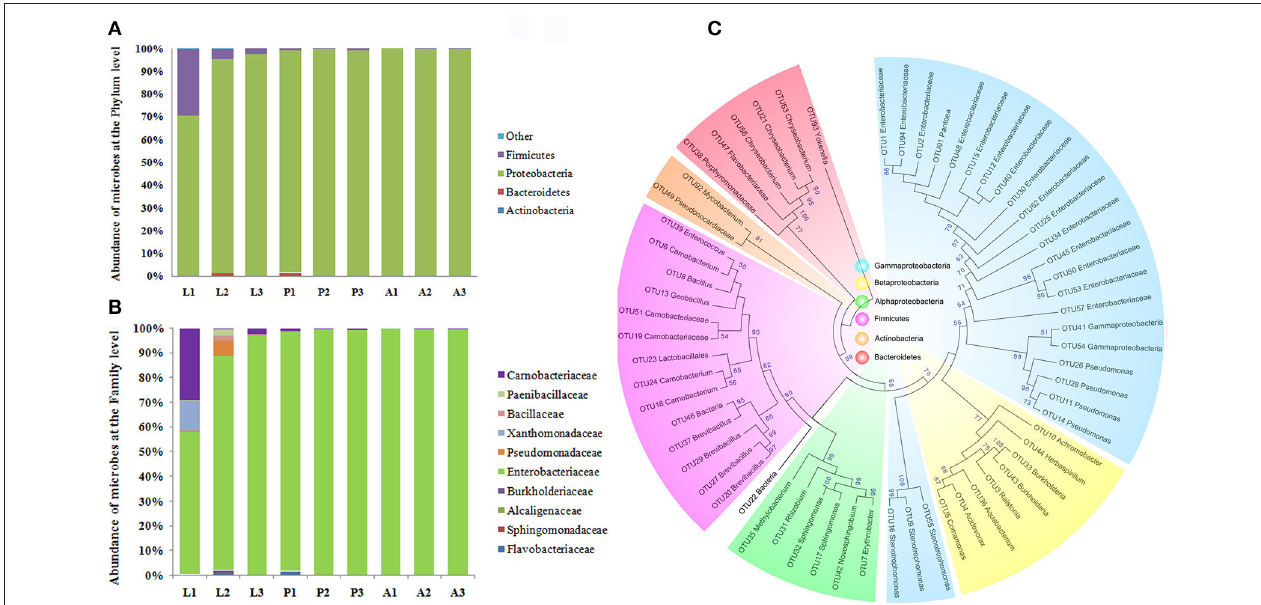
FIGURE 2 | Proportional composition of microbiota in the P. xylostella gut generated from the 454 pyrosequencing data. Composition at the phylum level (A) , and composition at the family level (B) , Neighbor-Joining method phylogeny of OTUs (C) . The phylogenetic tree revealed that the microbiota of P. xylostella gut were divided into six clusters corresponding with the phylum of Proteobacteria (Gammaproteobacteria was shown in blue, Betaproteobacteria with light yellow, and the alphaproteobacteria with green), Firmicutes (shown in purple), Actinobacteria (shown in dark yellow), and Bacteroidetes (shown in pink). Most of the sequences from the P. xylostella gut fell into the clusters of Proteobacteria and Firmicutes. Bootstrap values > 50 were shown in the